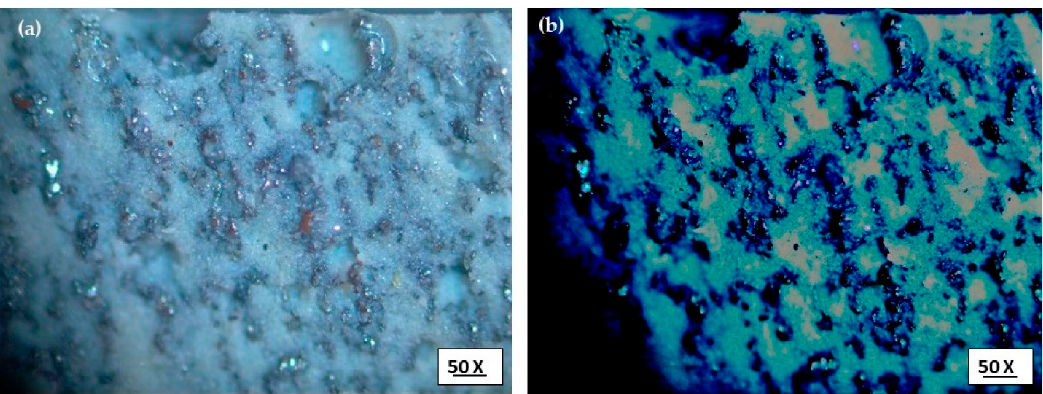
Figure 12. Anisotropic distribution filler within the elastomer composite in transverse ( a ) and longitudinal ( b ) direction from POM (polarizing optical microscope). Reprinted from [18], © 2018 with permission from MDPI.